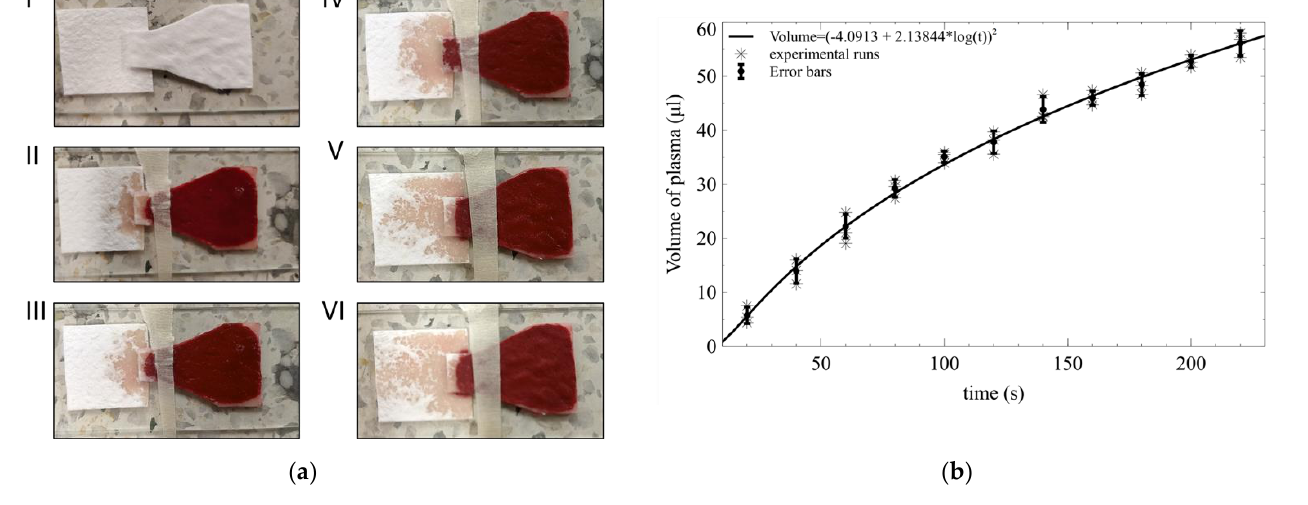
Figure 5. Blood plasma separation using the developed BPS device. ( a ) A total 300 μL was applied to the collection pad. Separation at I) t = 0 s; II) t = 40 s; III) t = 85 s; IV) t = 125 s; V) t = 170 s; VI) t = 210 s. ( b ) Volume of separated plasma as a function of time.